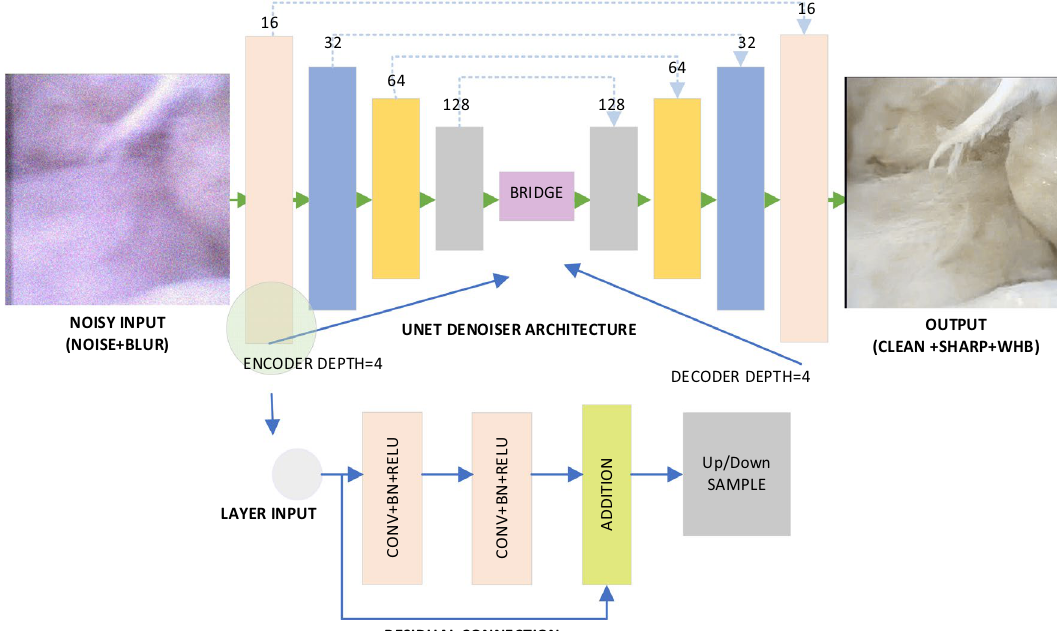
Figure 2. Architecture for endoscopic image restoration framework. A clean, sharp and white balanced (WHB) video frame is retrieved from its raw, noisy and blurred observation. The network depth for encoder and decoder is 4. The network uses residual connection as it is shown in the bottom image. Accumulated loss function calculated from PSNR, SSIM, perception loss and reduced mean of edge loss between noisy and clean